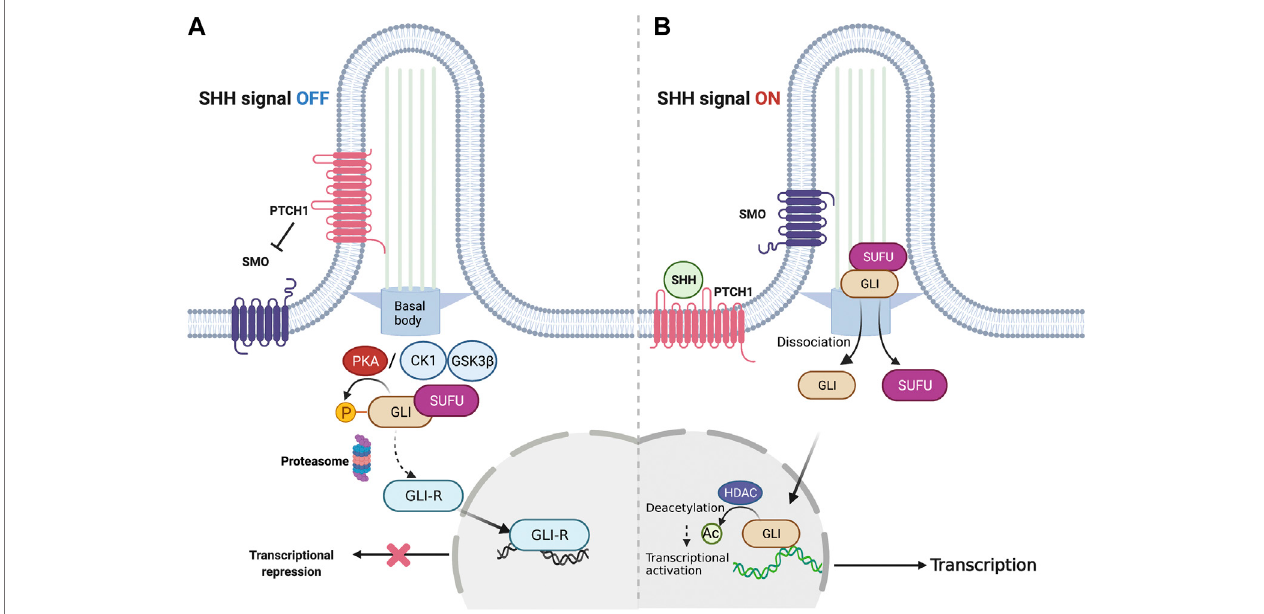
FIGURE 1 | Overview of canonical SHH signaling. (A) Representative signaling cascade when SHH signaling is shut off. In the absence of the SHH ligand, PTCH1 gets localized to the plasma membrane in the primary cilium and inhibits SMO. This causes the GLI family proteins to stay restrained by SUFU to facilitate their phosphorylation by PKA. Consequently, the GLI proteins undergo proteolysis to generate GLI-R that suppresses the transcription of target genes. (B) Representative signaling cascade when the SHH signaling isswitched on. In thepresence ofthe SHH ligand, PTCH1 gets inhibited by theSHH ligand-dependent interaction. This activatesSMO,allowingitstranslocationtothecilia.Subsequently,GLIproteinsdissociatefromSUFUtoenterthecellnucleusandactivatethetargetgenes.SHH,Sonic hedgehog; PTCH1, Patched1; SMO, Smoothened; GLI, Glioma-associated oncogene; SUFU, Suppressor of fused; PKA, Protein kinase A.